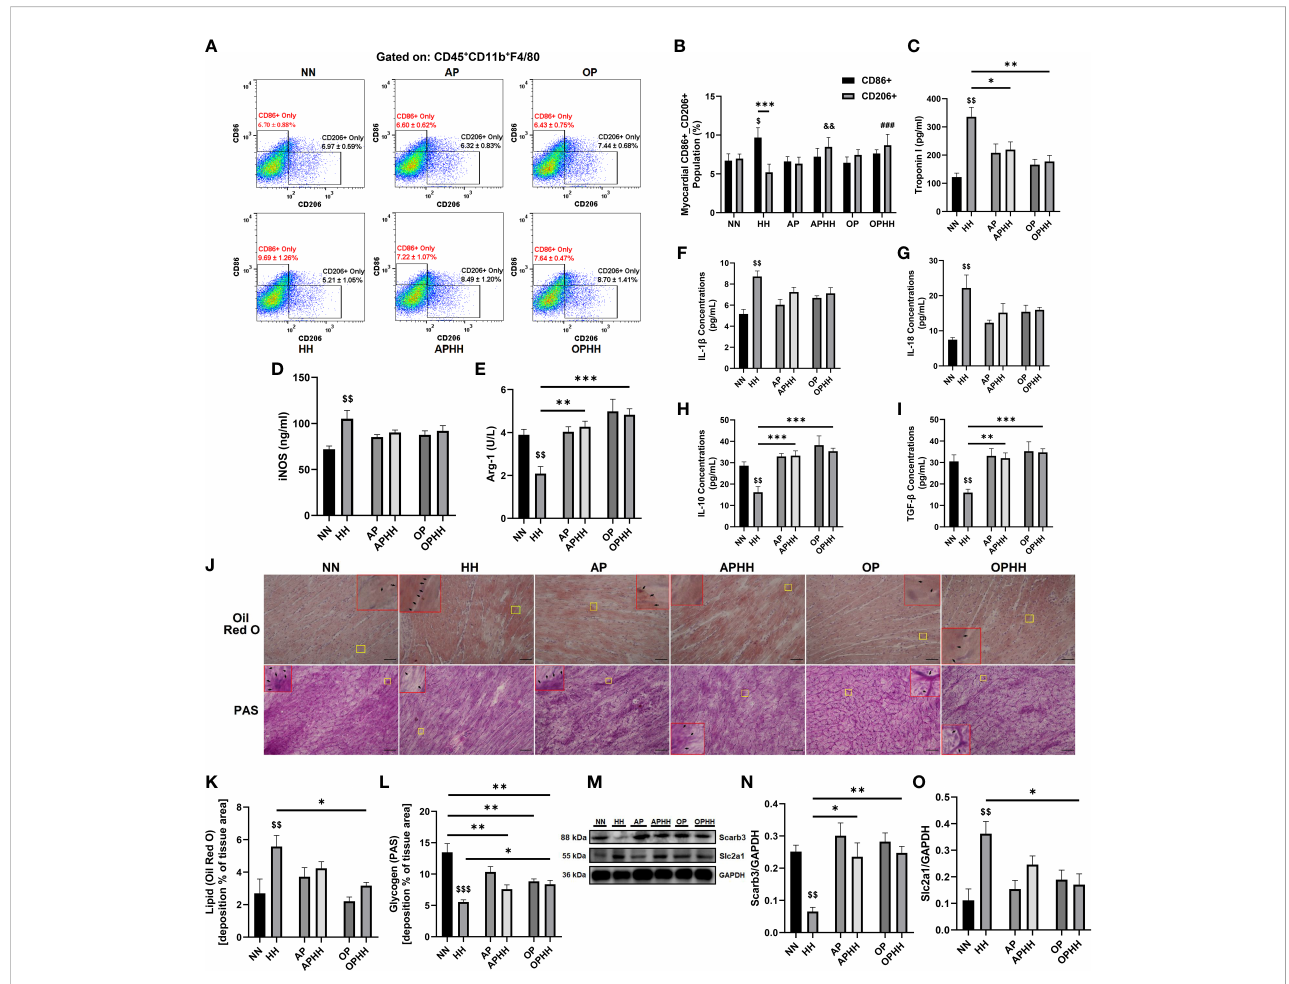
FIGURE 3 OP induces adaptive immunomodulation and metabolic homeostasis during hypobaric hypoxia. (A, B) Representative fl ow cytometry of myocardial macrophages gated on CD45 + CD11b + F4/80 and Graphical plots of CD86 + and CD206 + . Normobaric Normoxia (NN), Hypobaric Hypoxia (HH), Altitude Preconditioned (AP), Altitude Preconditioned before HH exposure (APHH), Occlusion Preconditioned (OP), and Occlusion Preconditioned before HH exposure (OPHH) mice hearts (n=4 hearts per group). $ p<0.05 vs NN CD86+ ; ## p<0.01, ### p<0.001 vs HH CD206+ (C) Graphical presentation of sera cardiac troponin I (cTnI) concentrations. (D, E) In fl ammatory mediators; Inducible nitric oxide synthase (iNOS) and Arginase-1 (Arg-1) concentrations assessed by ELISA using myocardia lysates. (F-I) In fl ammatory cytokines; Interleukin (IL)-1 b , IL-18, IL-10, and transforming growth factor (TGF)- b concentrations assessed by ELISA using myocardia lysates. All ELISA were performed in triplicates (n= 5-8 mice per group). (J-L) Representative Oil Red O (ORO) and Periodic Acid Schiff (PAS) staining of myocardial sections and their respective graphical presentations showing lipid and glycogen depositions percentages (n=4-6 sections per 4-6 mice per group). Yellow outlined boxes are original myocardial portions and red outline boxes are their zoomed-in (5x) inserts to show positive stained area (indicated with black arrows). (M-O) Representative Immunoblotting of Scarb3 and Slc2a1 and their respective Graphical plots; each blot band in the representative blot is an independent biological sample (n= 3 hearts per group). $$ p<0.01, $$$ p<0.001 HH vs NN; && p<0.01 APHH vs AP; * p<0.05, ** p<0.01, *** p<0.001. Data are expressed as mean ± SEM. Data were analyzed using one-way ANOVA, followed by Tukey ’ s post hoc